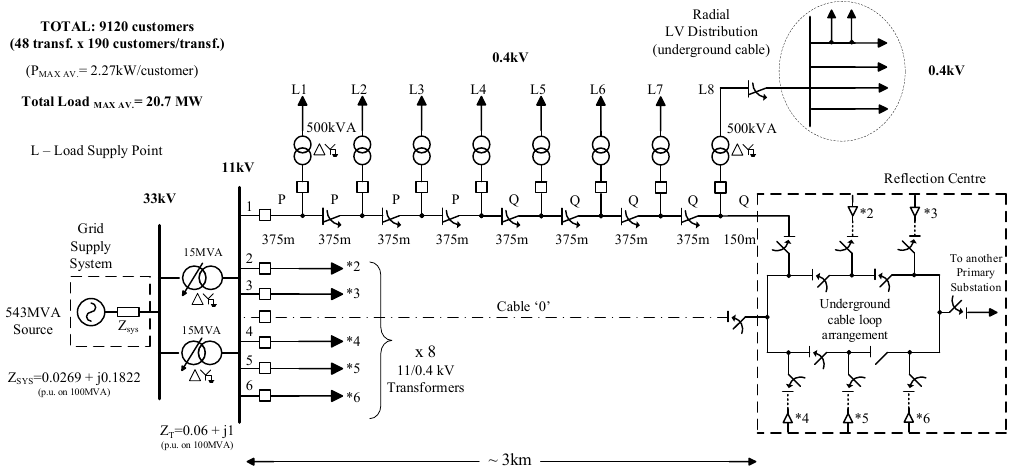
Figure 3. Urban generic MV distribution network model incorporating aggregated LV models from Figure 2 (with corresponding equivalent failure rates and mean repair times).